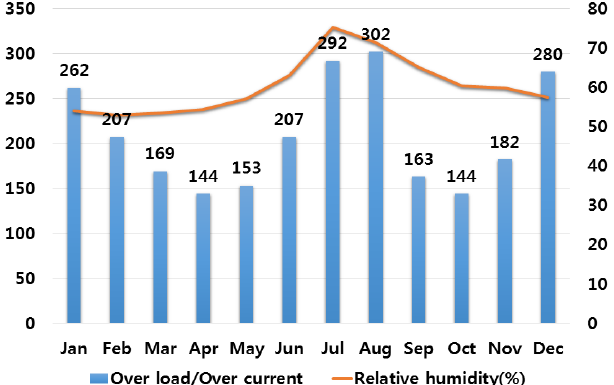
Figure 8. Correlation between the number of fires caused by overload/over current and the average humidity on a monthly basis.